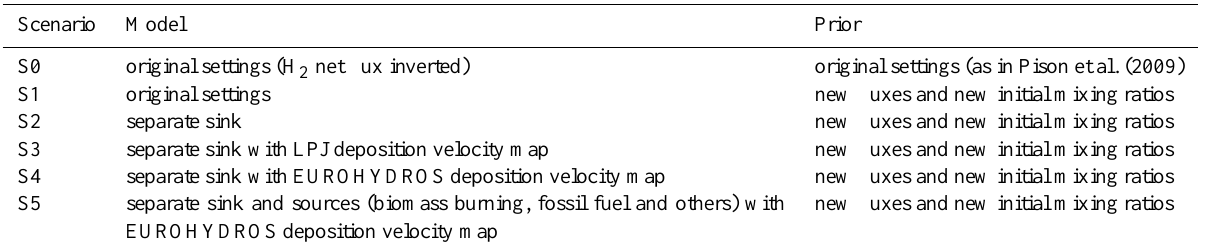
Fig. 4. The three soil deposition velocity maps used in this study. Top: from Hauglustaine and Ehhalt (2002), middle: from Sitch et al. (2003), bottom: from Oslo CTM2 based on Schillert (2010). White pixels are missing values. Table 3. Scenarios used in this 38